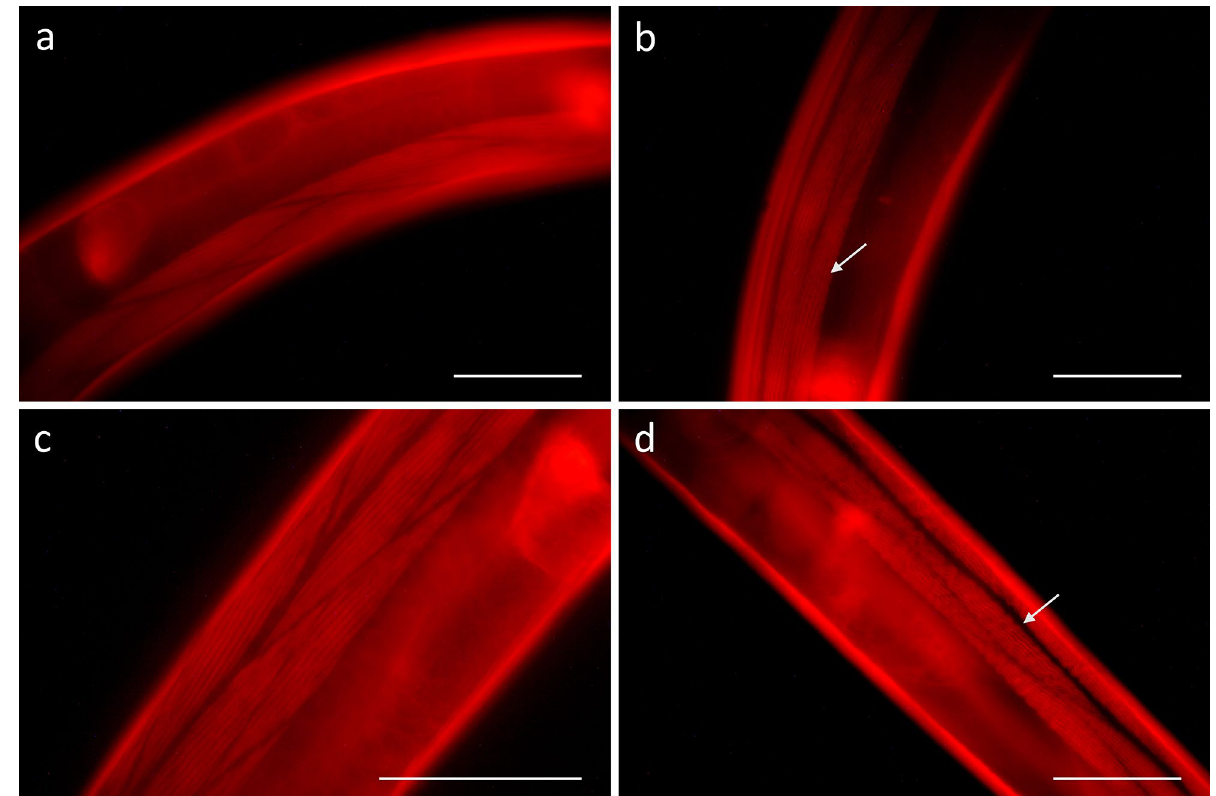
Figure 4. Fluorescence microscopy of young adult C. elegans stained with Texas Red-Phalloidin after 24 h and 48 h of treatment in liquid culture, resp., followed by 6 h of regeneration on NGM agar. Left panel: Untreated control (M9 buffer with 1% DMSO) after for 24 h ( a ) or 48 h ( b ). Right panel: Worms treated with CM (2 mg/ mL) for 24 h ( c ) or 48 h ( d ). Scalebar 50 µm. White arrows indicate wavy structures of the actin filaments in extract treated